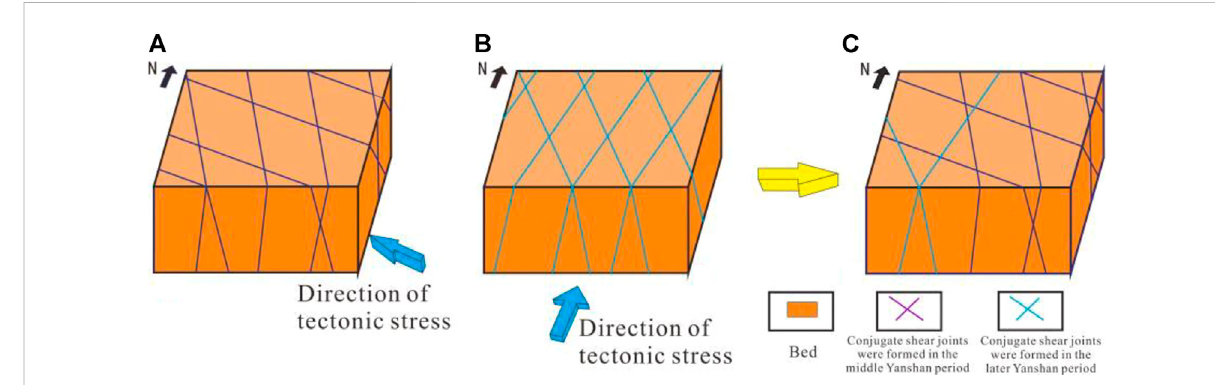
FIGURE 11 DevelopmentalmodeofconjugateshearfracturesinLintanchangArea.( (A) :StrikingofconjugateshearfracturesformedintheMid-Yanshanian period; (B) Striking of conjugate shear fractures formed in the Late Yanshanian period; (C) Distribution of conjugate shear fractures).